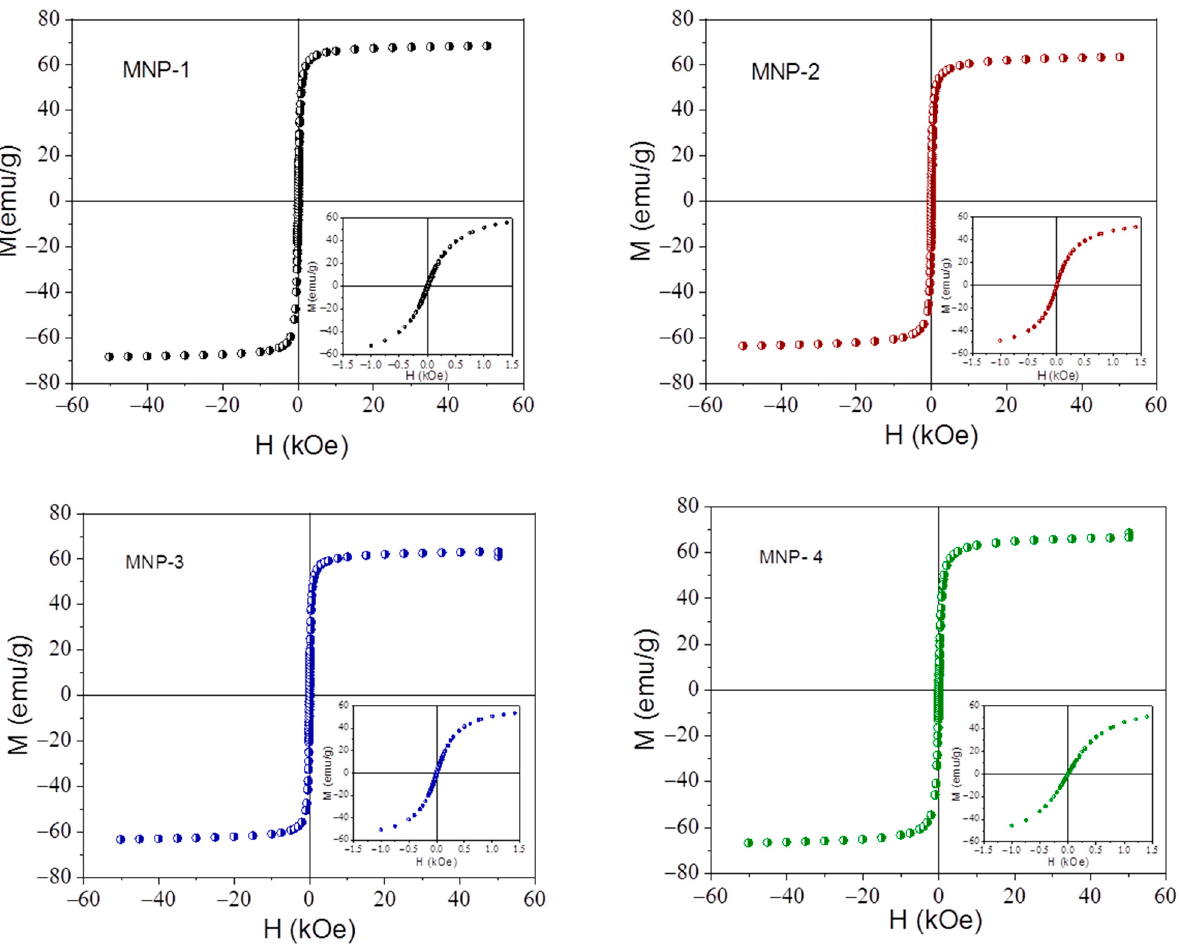
Figure 3. Magnetization cycles of samples MNP-1 , MNP-2 , MNP-3 , and MNP-4 . Insets: Low-field regions.